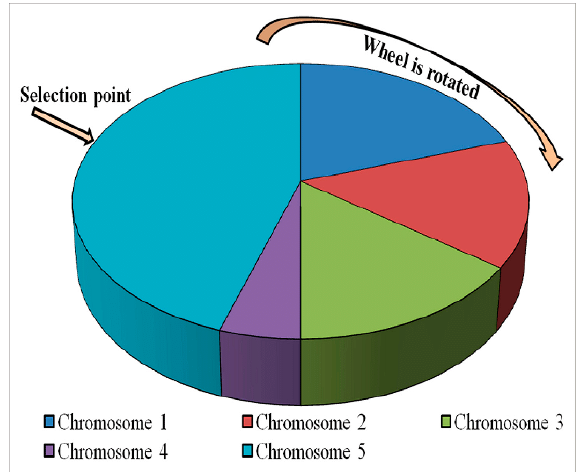
Figure 10. Depiction of roulette Wheel selection.